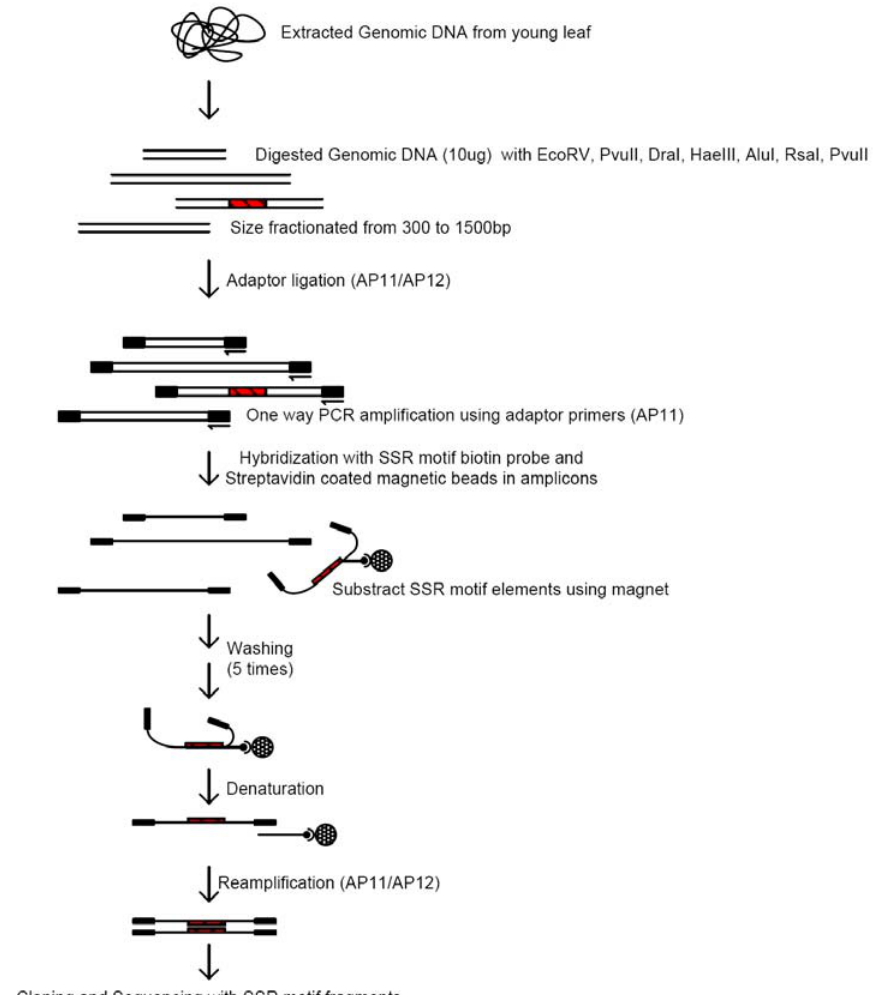
Figure 4. A general protocol for developing SSR markers with a SSR-enrichment